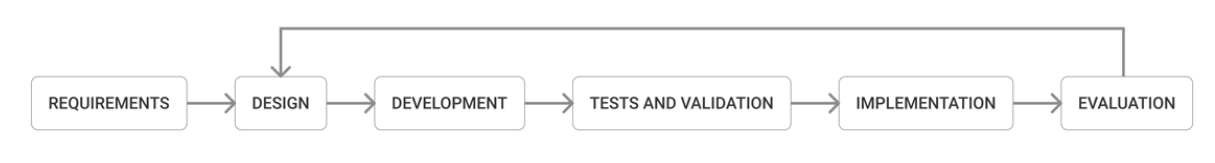
Figure 7. General view of the iterative development